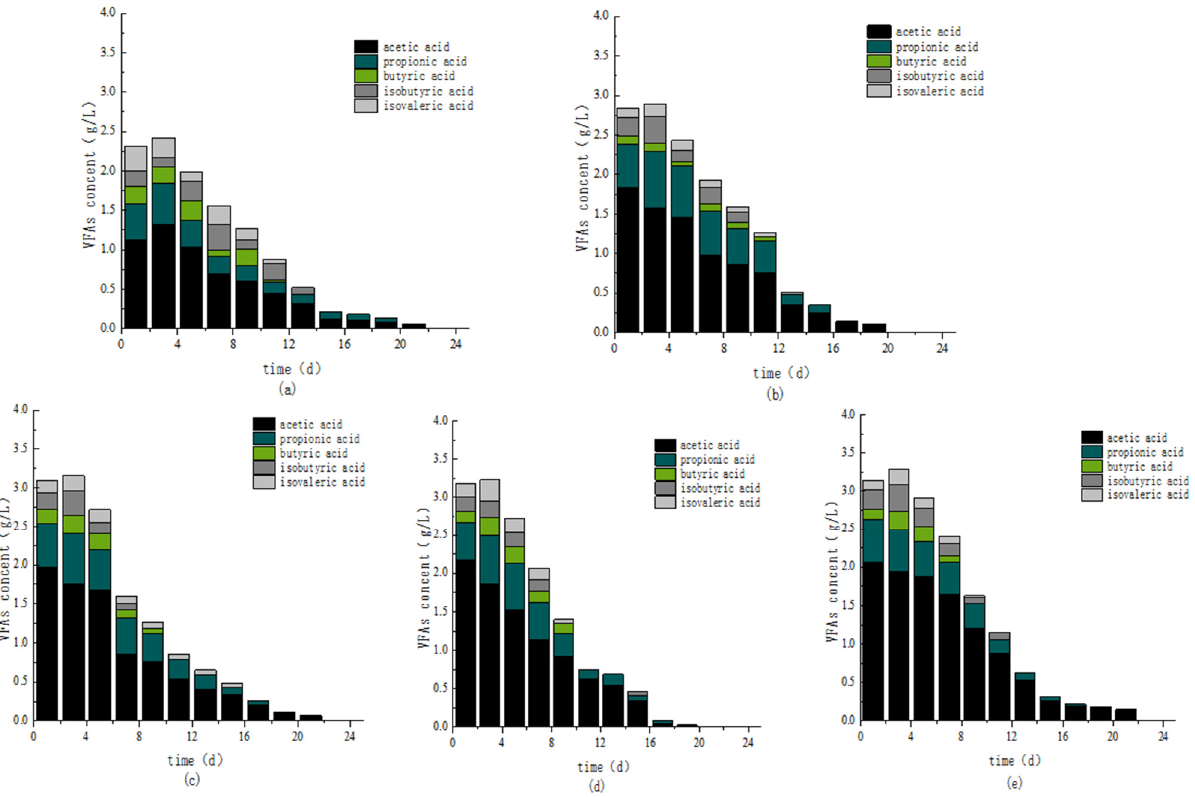
Figure 8. Effect of biogas slurry reflux on volatile fatty acid content. ( a ) CK group ( b ) T1 treatment, ( c ) T2 treatment, ( d) T3 treatment, ( e ) T4 treatment.